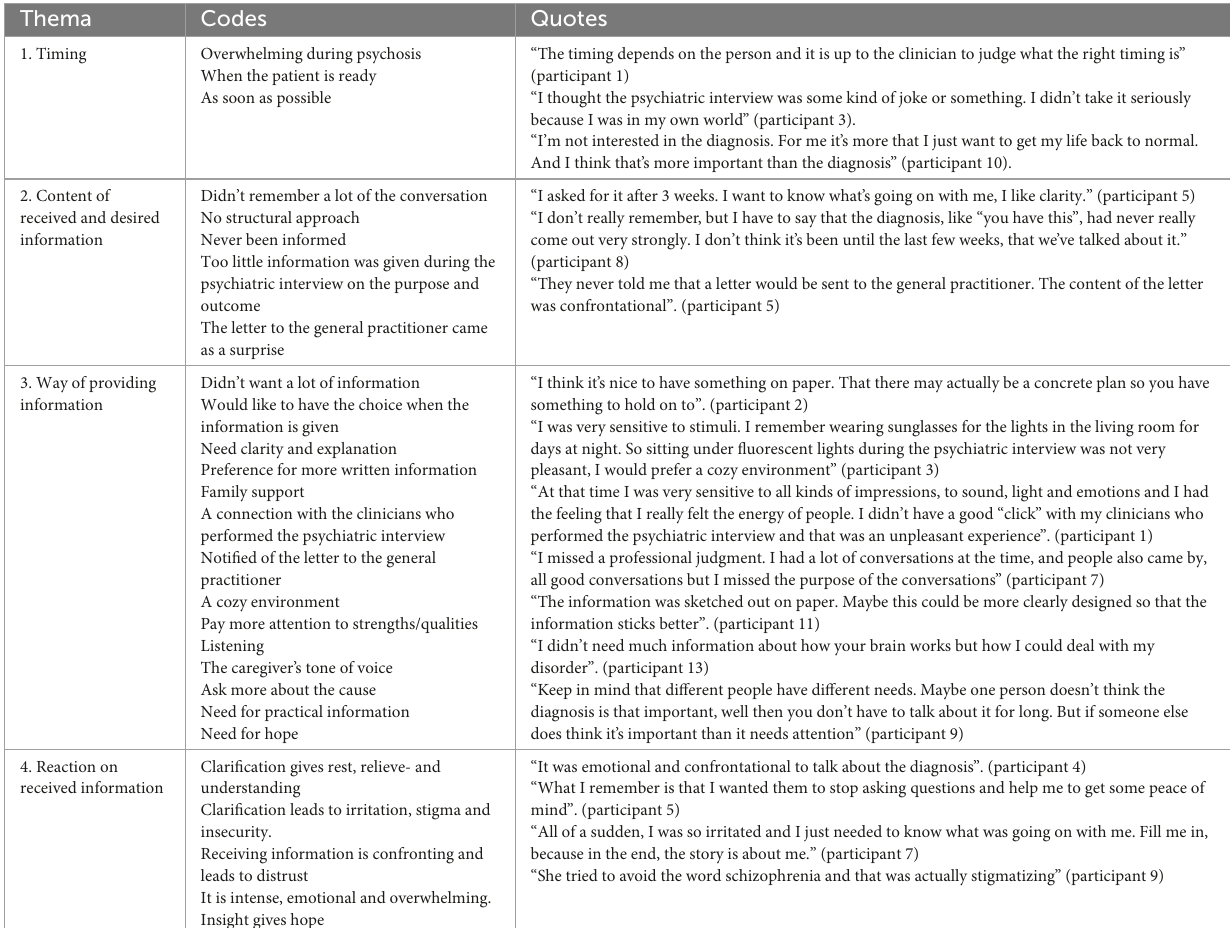
TABLE 2 Experiences of the communication of diagnostic information in patients after FEP: examples of the phenomenological process using thematic analysis [Braun and Clark (29)]. Thema Codes